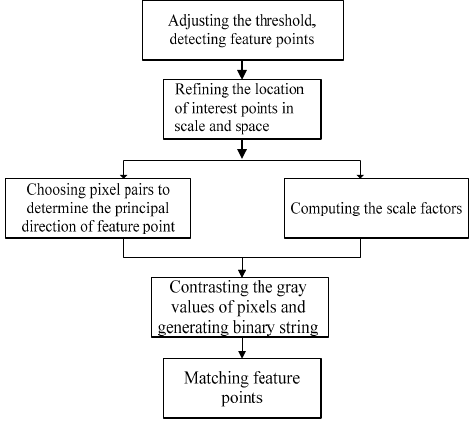
Figure 3. the flow of improved BRISK algorithm. Figure 3. The flow of improved BRISK